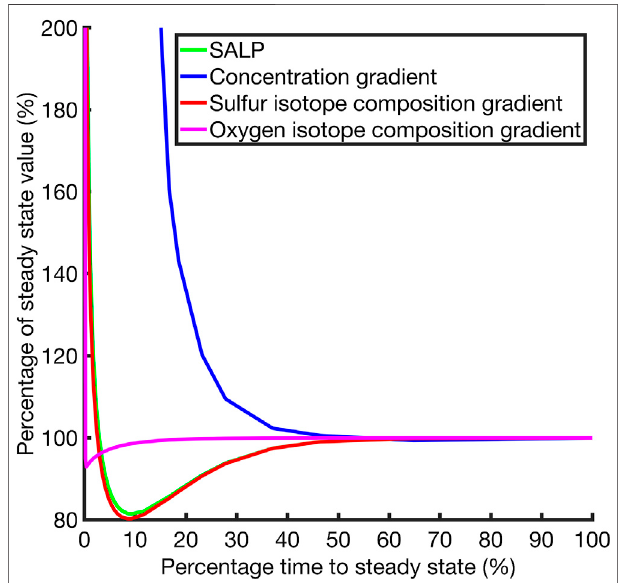
FIGURE 5 | Plot of the slope of the apparent linear phase for the δ 34 S and δ 18 O cross plot and other quantities plotted against the percentage progress to steady state through time. Case 1, r (cid:2) 14.